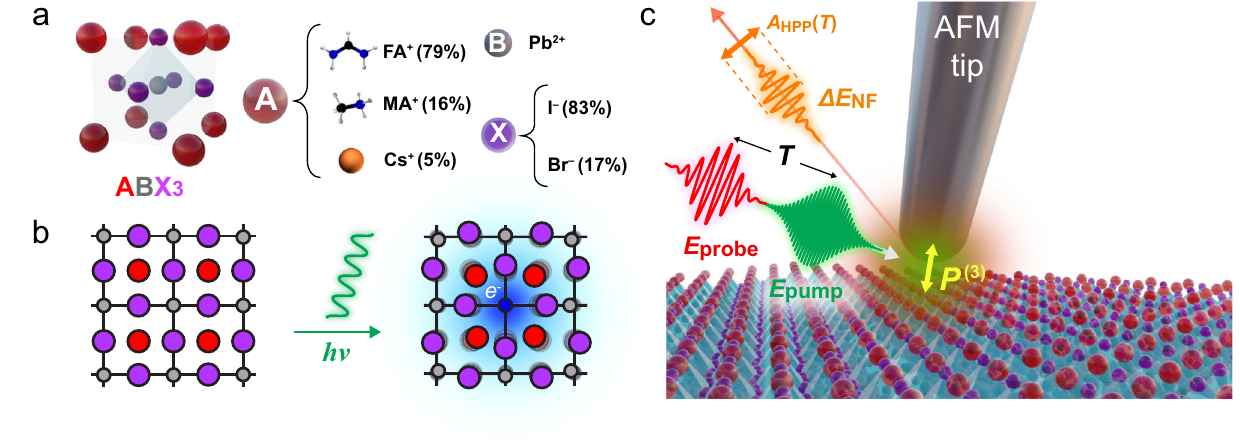
Fig. 1 | Principle of perovskite ultrafast infrared nano-imaging. a Unit cell structure of the triple cation perovskite ½ð FA 0 : 83 MA 0 : 17 Þ 0 : 95 Cs 0 : 05 (cid:2) Pb ð I 0 : 83 Br 0 : 17 Þ 3 . b Photoinduced polaron formation in perovskites. An injected photoinduced car- rier is self-trapped by the deformation of the surrounding lattice. c Ultrafast